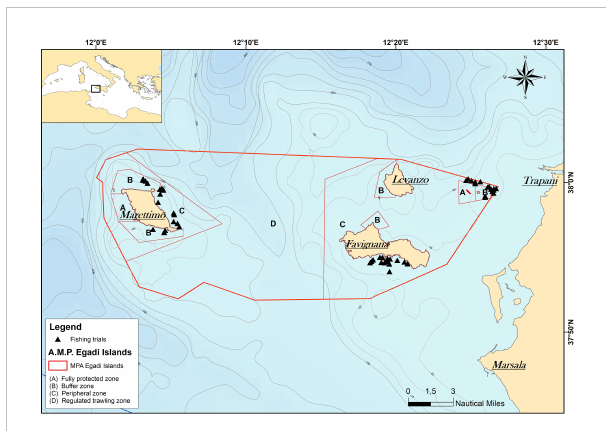
FIGURE 1 Map showing the location of the study. Red line, boundaries of the Egadi Islands MPA; Black triangles: sites of fi shing trials; letters, existing sectoral initiatives in the marine protected